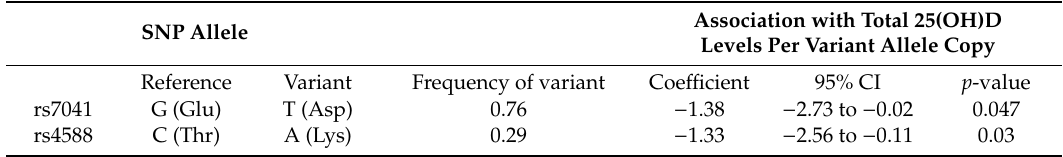
Table 2. Allele frequencies of DBP and its e ff ect on total 25(OH)D